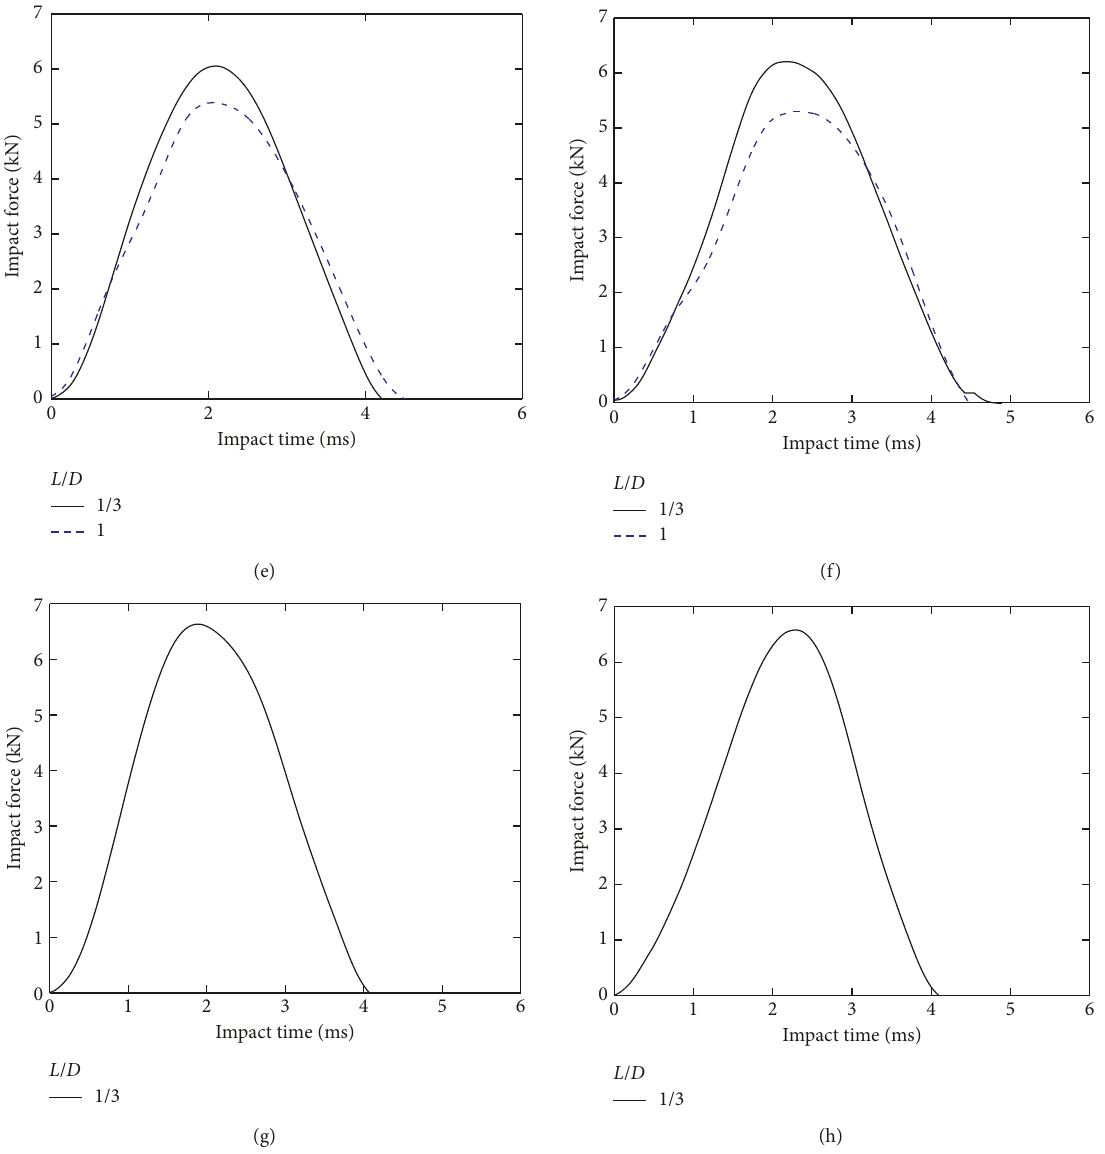
Figure 10: Time history of impact force at room temperature. (a) 1st impact. (b) 3rd impact. (c) 6th impact. (d) 9th impact. (e) 12th impact. (f) 14th impact. (g) 18th impact. (h) 21st